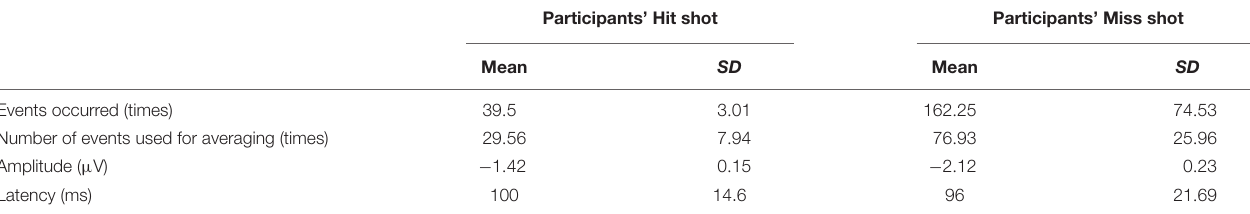
TABLE 1 | Summary of event-related